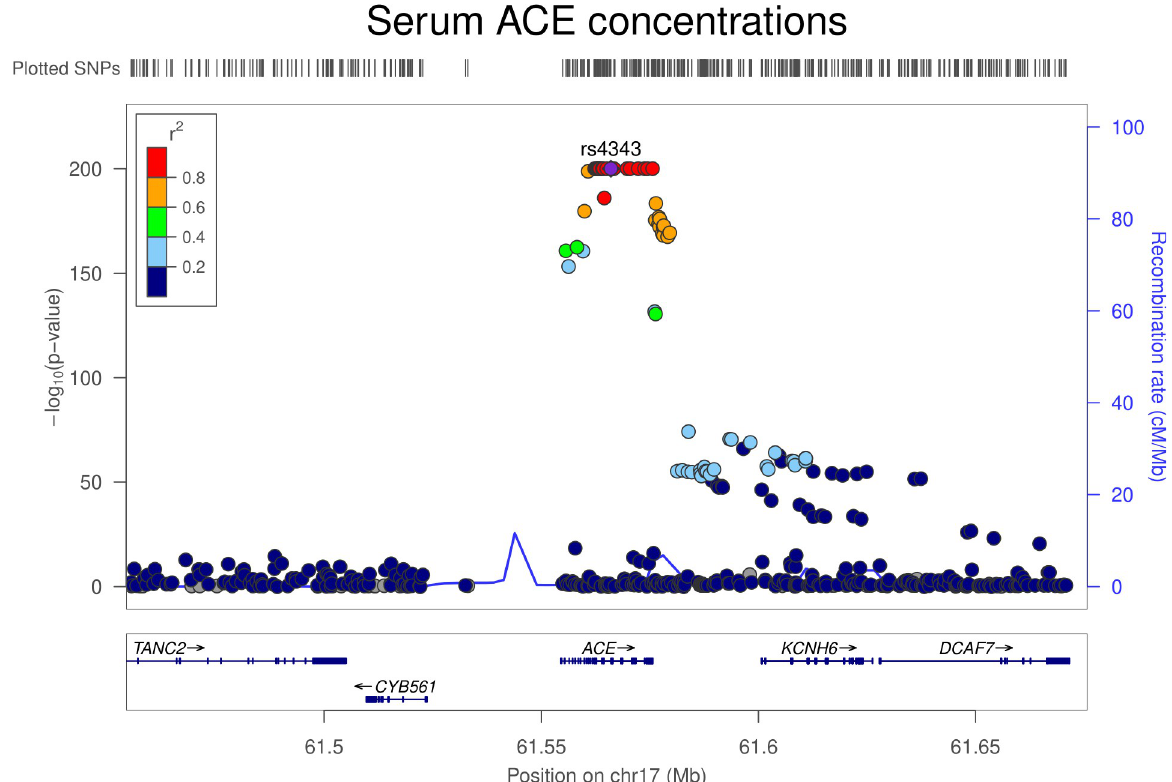
Fig 1. Regional Manhattan plot of associations of SNPs with serum ACE concentrations ± 300kb from the SNP used to proxy serum ACE concentrations (rs4343) in the ACE region. ACE AU : AbbreviationlistshavebeencompiledforthoseusedinFigs 1 (cid:0) 8 : Pleaseverifythatallentriesarecorrect : , angiotensin-converting enzyme; Mb, Megabase; SNP, single-nucleotide polymorphism.